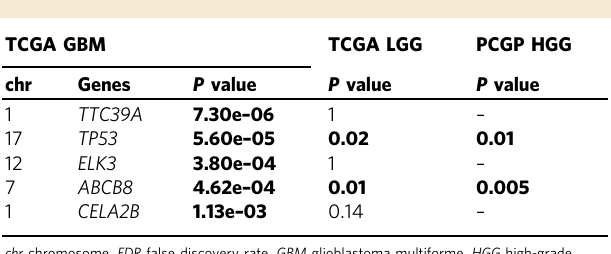
Table 3 The top candidate genes from the TCGA GBM